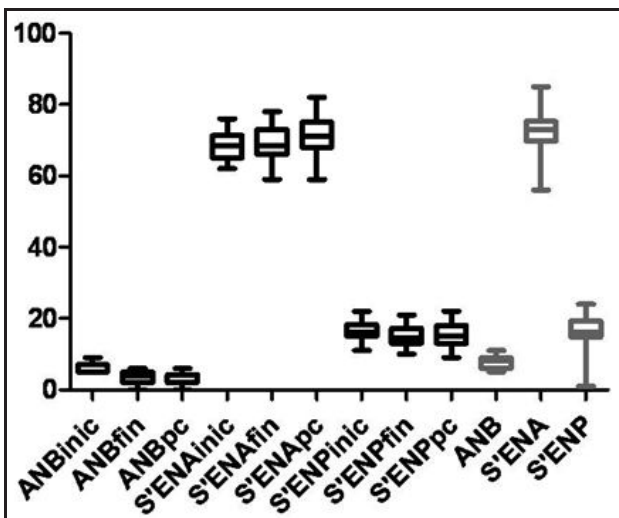
Fig. 2. Values of ANB value and of the linear measurements S’ENA and S‘ENP in the treated group at the time intervals before treatment (T (T ) and with a minimum of 5 years post-retention (T 1